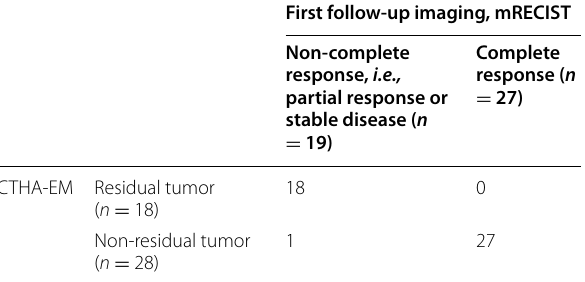
Table 2 Diagnostic accuracy of intra‑procedural